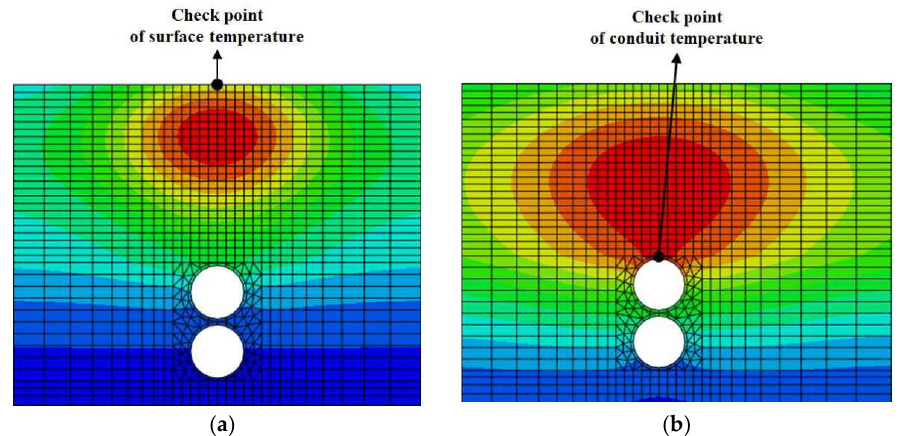
Figure 5. Checkpoint of FEA results. ( a ) Pavement surface temperature; ( b ) Conduit temperature.